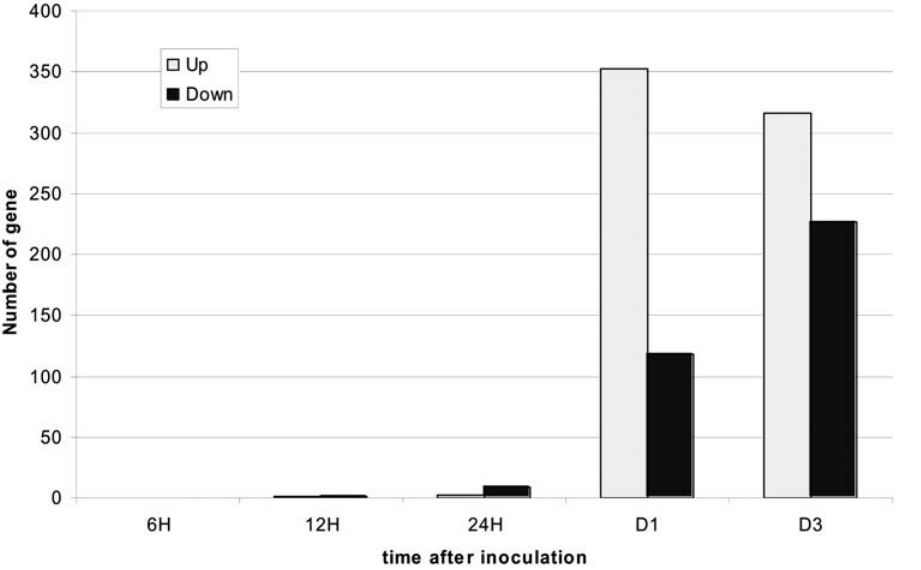
Figure 1. Diagram showing the number of up- and down-regulated genes (in white and black, respectively) identified by microarray analysis in both compatible interactions (Col-0/GMI1000 and Nd-1/GMI1000 D PopP2) versus the incompatible interaction (Nd-1/GMI1000) at different times after pathogen inoculation. Up-regulated genes were selected using Signal Log 2 Ratio $ 1, and down-regulated genes using a Signal Log 2 Ratio #2 1, using a corrected p-value # 0.05 for both classes of genes.